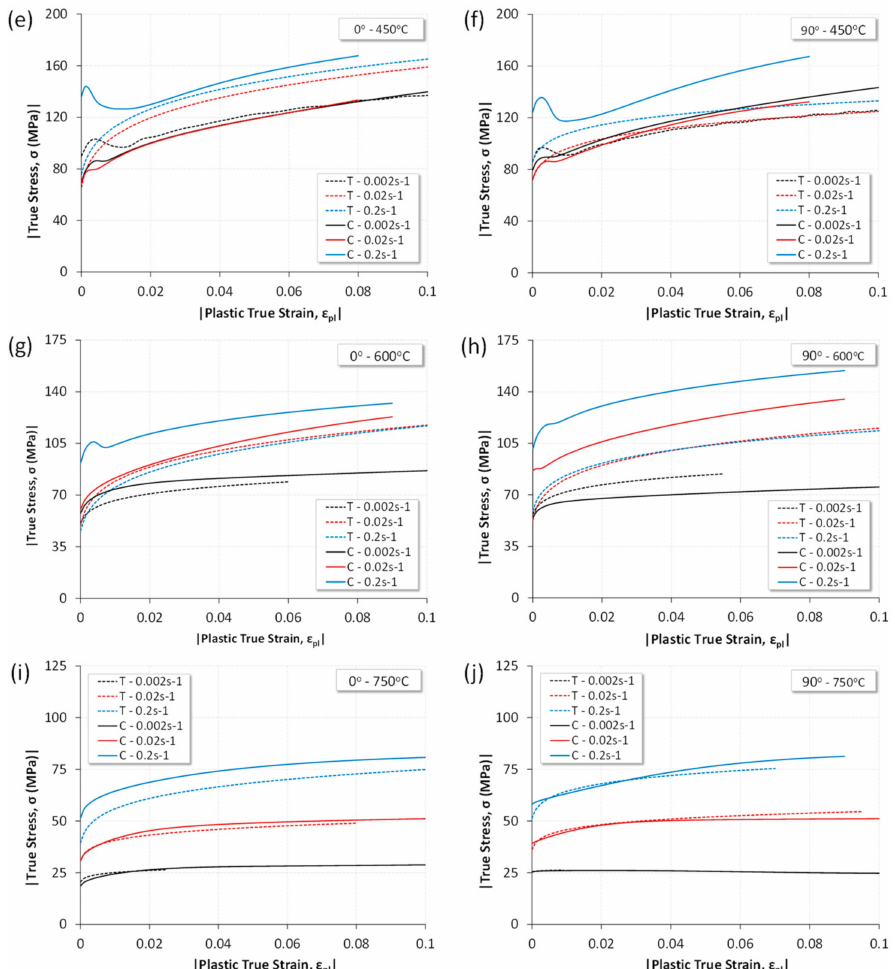
Figure 12. Tension and compression behavior of Ticp2 at temperatures of 25, 300, 450, 600, and 750 ◦ C, and strain rates of 0.002, 0.02, and 0.2 s − 1 . ( a , c , e , g , i ) Mechanical behavior in rolling direction